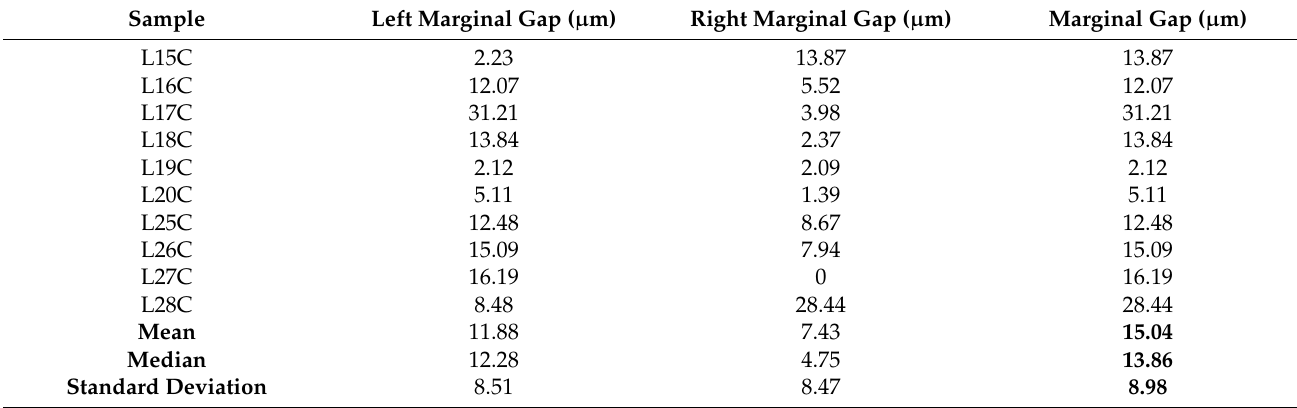
Table 4. Marginal adaptation in the control